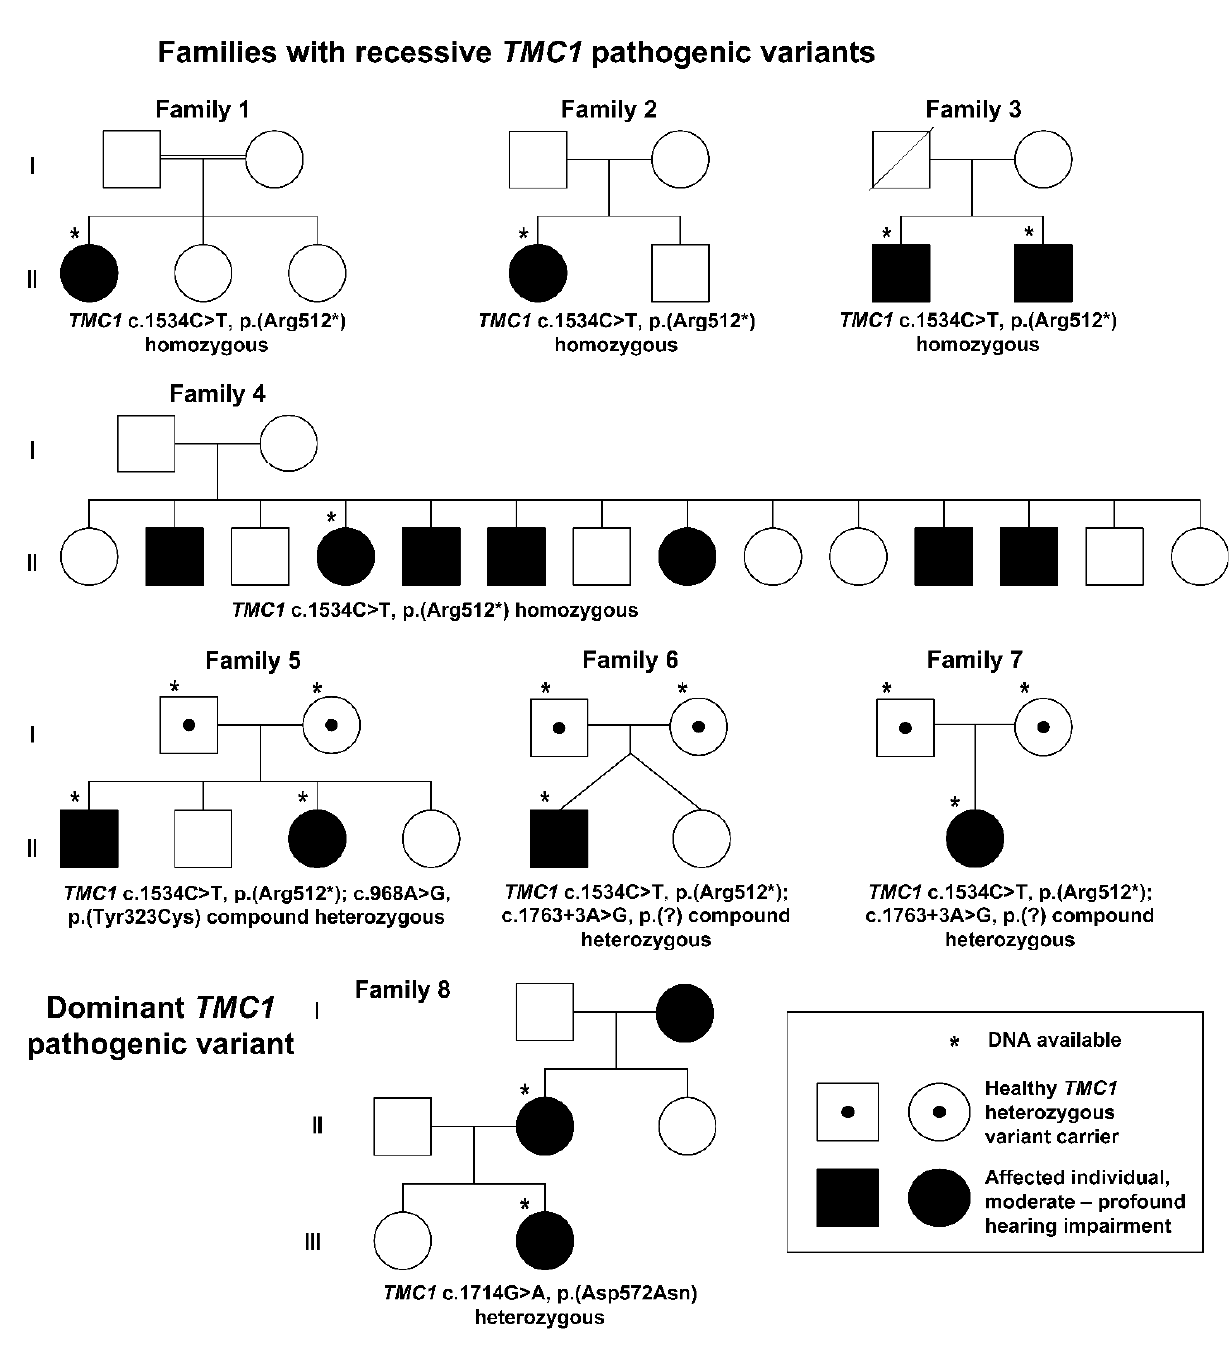
Figure 1. Pedigrees of the families in two (I–II) or three (I–III) generations. In six families, the TMC1 c.1534C>T, p.(Arg512*); c.968A>G, p.(Tyr323Cys), and c.1763+3A>G, p.(?) variants segregated reces-